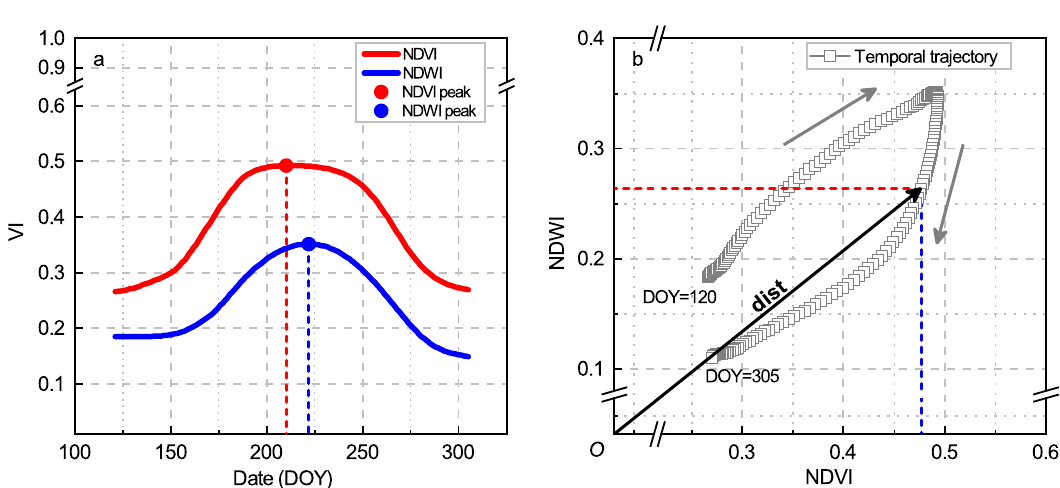
Figure 3. Schematics showing ( a ) the normalized difference vegetation index (NDVI) and normalized difference water index (NDWI) time series in date-VI form and ( b ) the calculation of dist (the distance from the pixel to the origin in the phase–space) in the corresponding NDVI–NDWI phase–space for an example rice